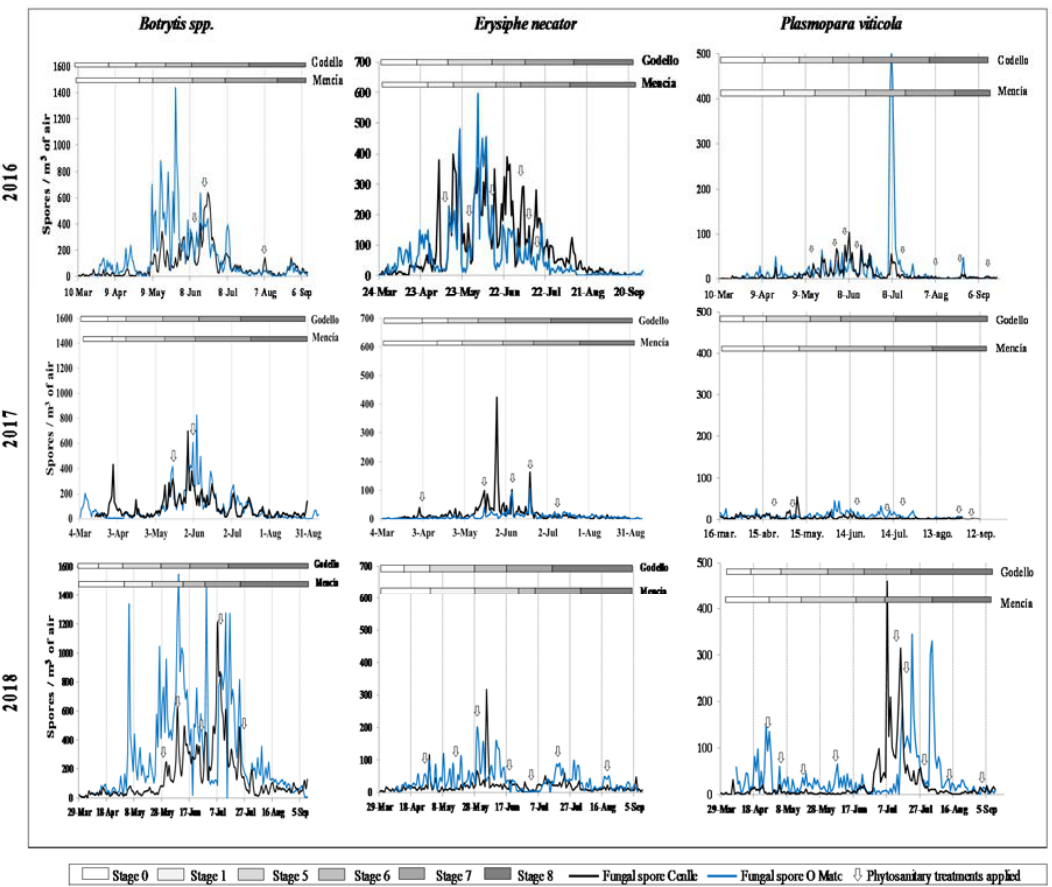
Figure 2. Phenology, spore concentrations, and phytosanitary treatments applied in the three study years for Ribeiro (Cenlle) and Ribeira Sacra (O Mato) vineyards.